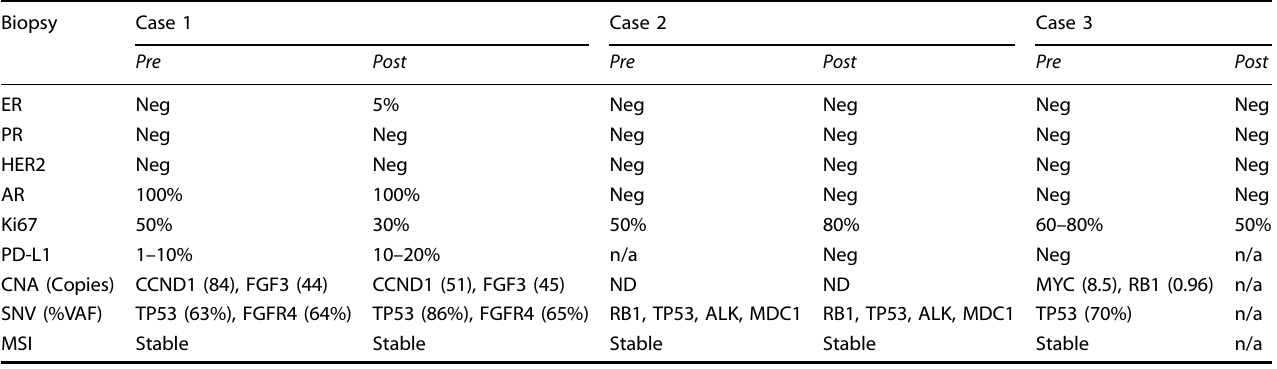
Table 3. Tumor ’ s